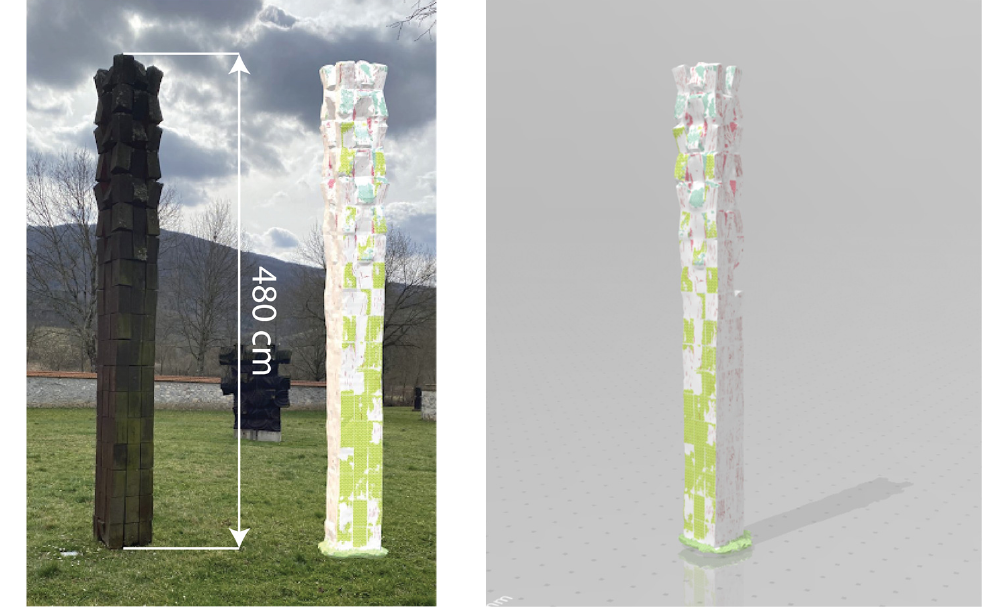
Figure 4. A result of the 3D graphic presentation of the sculpture Tower of Babel pasted next to the original sculpture (mentor: Prof. Dr. Denis Tr č ek; Author: Lara Skukan).